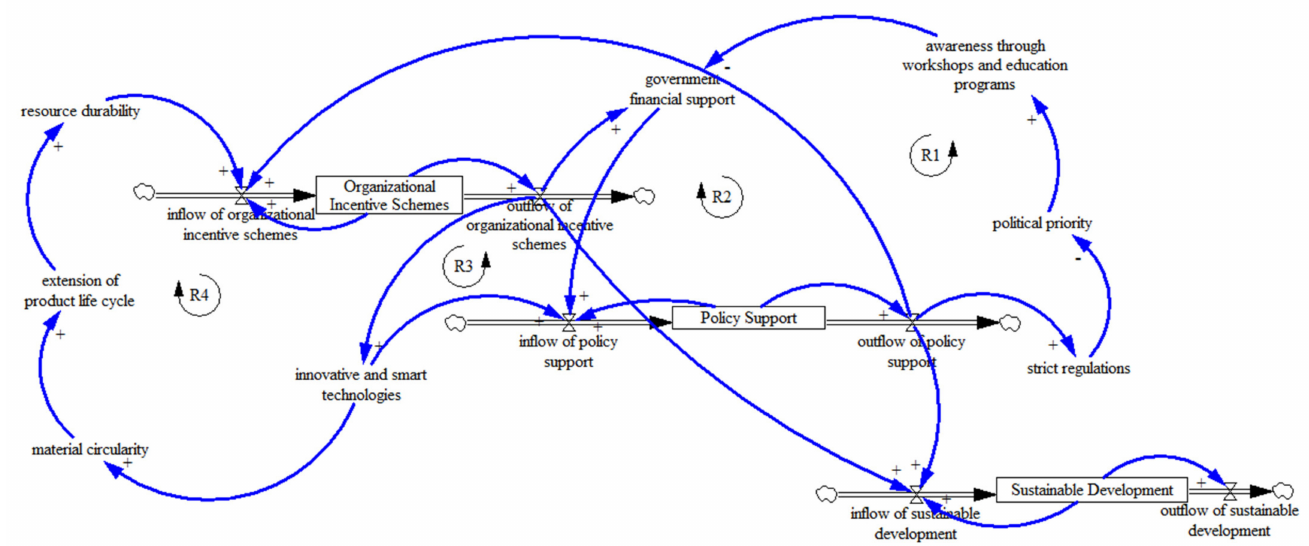
Figure 11. System Dynamics Model.